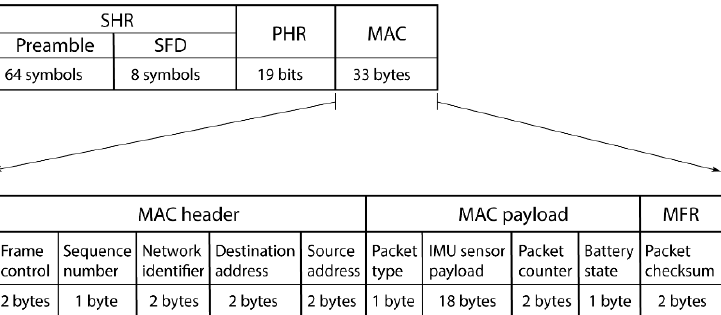
Figure 3. Synchronization header (SHR), the Physical Layer Header (PHR) and the Medium Access Control (MAC) portions of the frame, each with subfields identified.